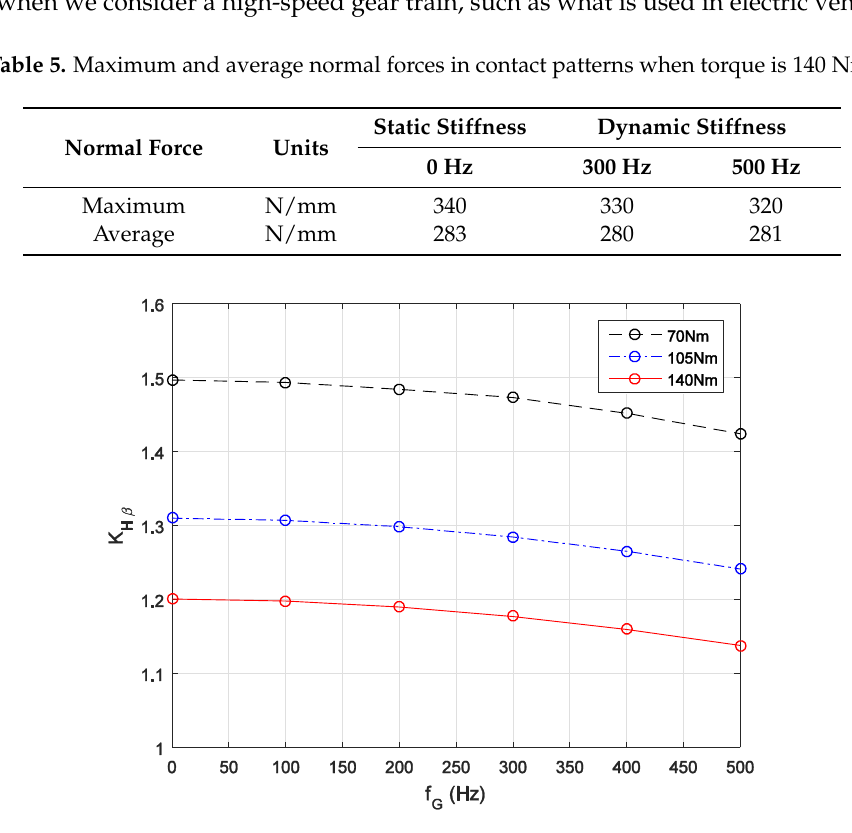
Figure 11. Transmission error depending on gear mesh frequency when torque is 140 Nm.